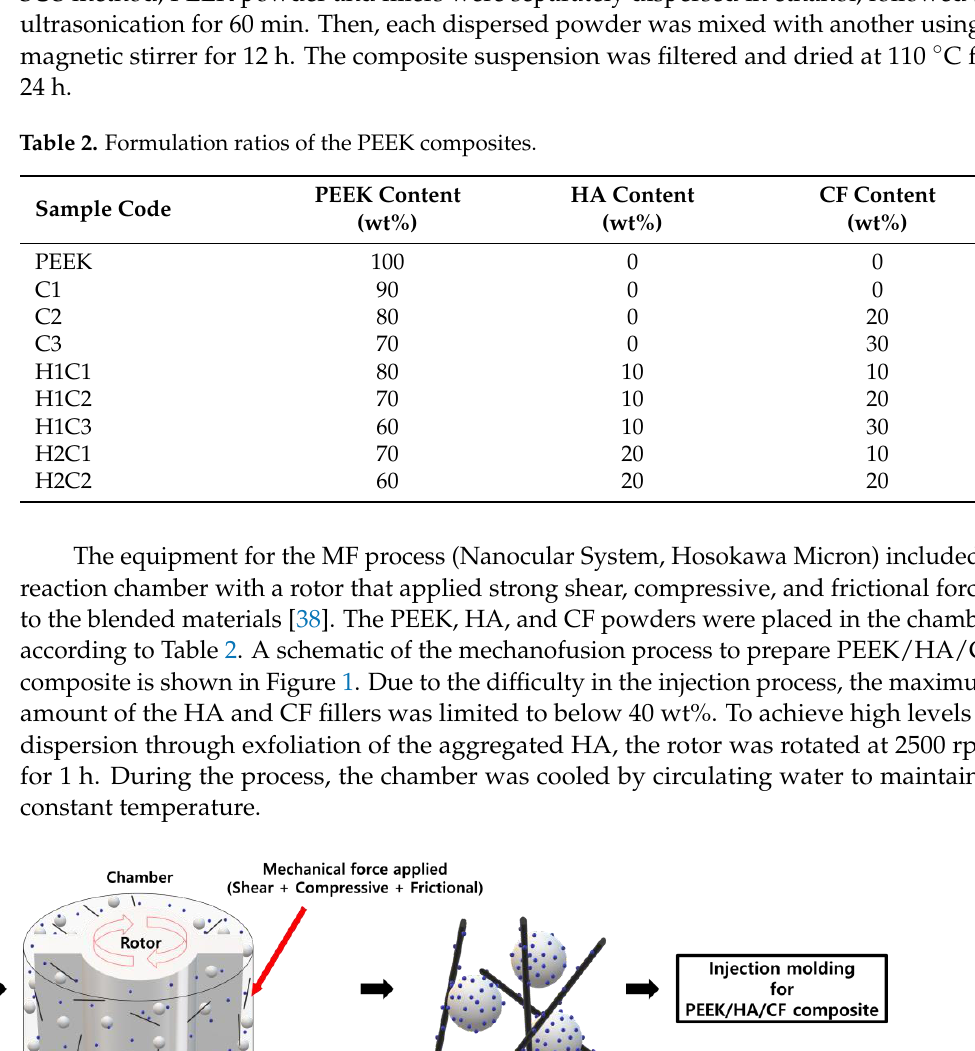
Table 2. Formulation ratios of the PEEK composites.